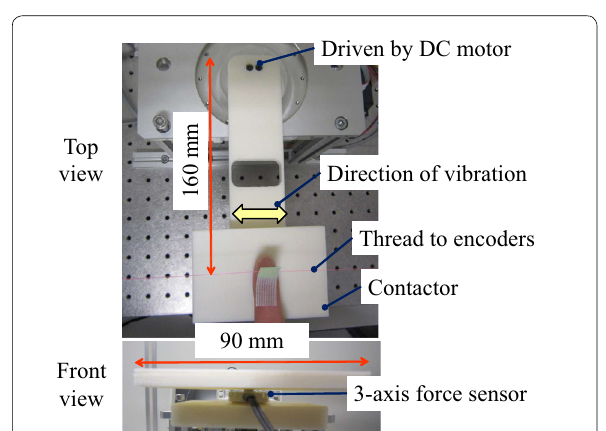
Fig. 4 Lateral vibrotactile display with a three-axis force sensor. Two encoders (not shown) measured the fingertip position by being attached to a thread taped to the finger nail